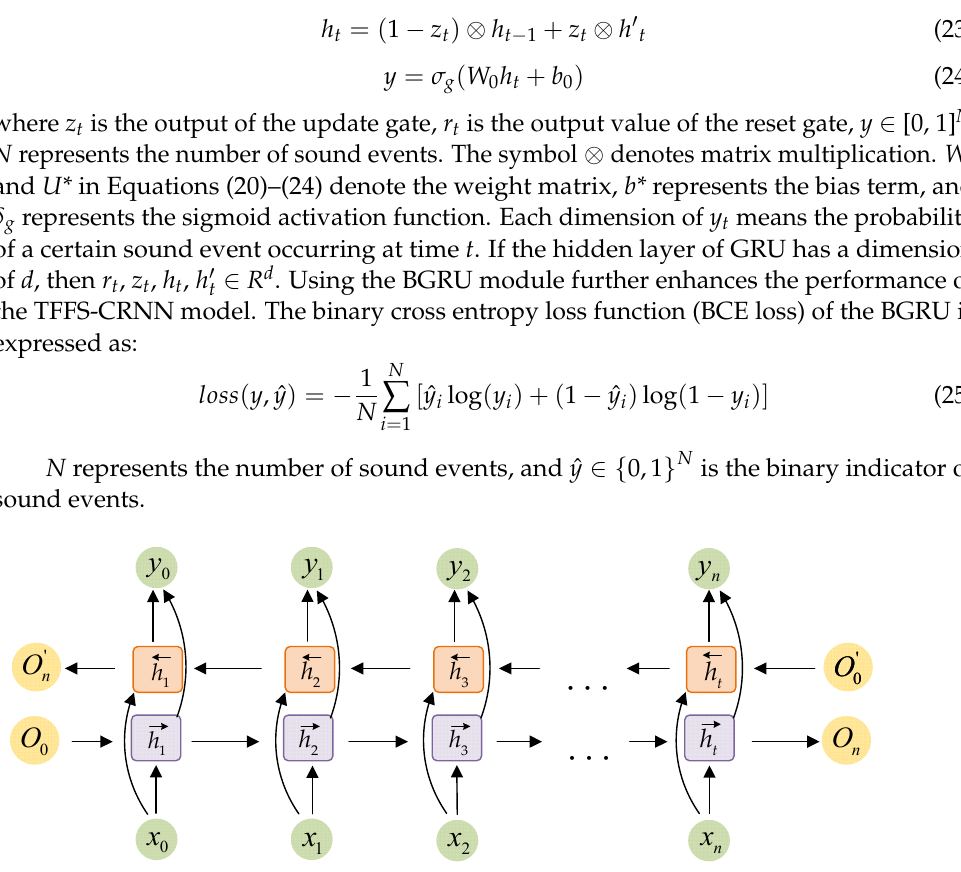
Figure 4. The BGRU model includes the forward GRU and the backward GRU. The input sequence is X = [ x 0 , x 1 , … , x n ]. The BGRU model is computed from x 0 forward and then from x n backward. The final output is the combination of the forward output and backward output.